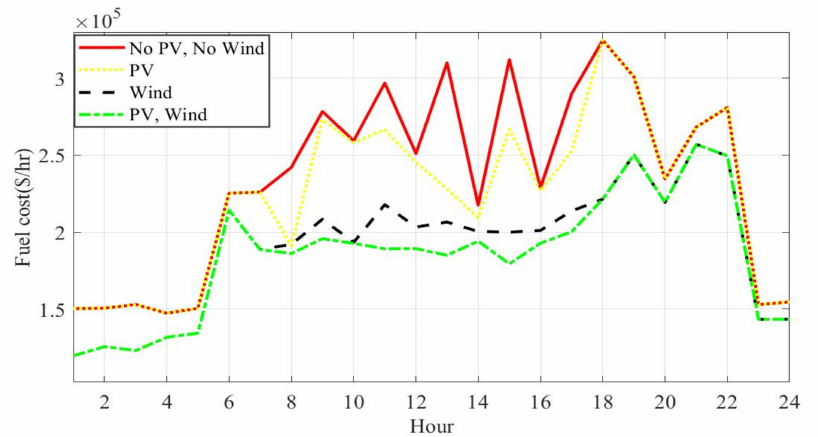
Figure 15. Hourly fuel cost in the case of the 118-bus